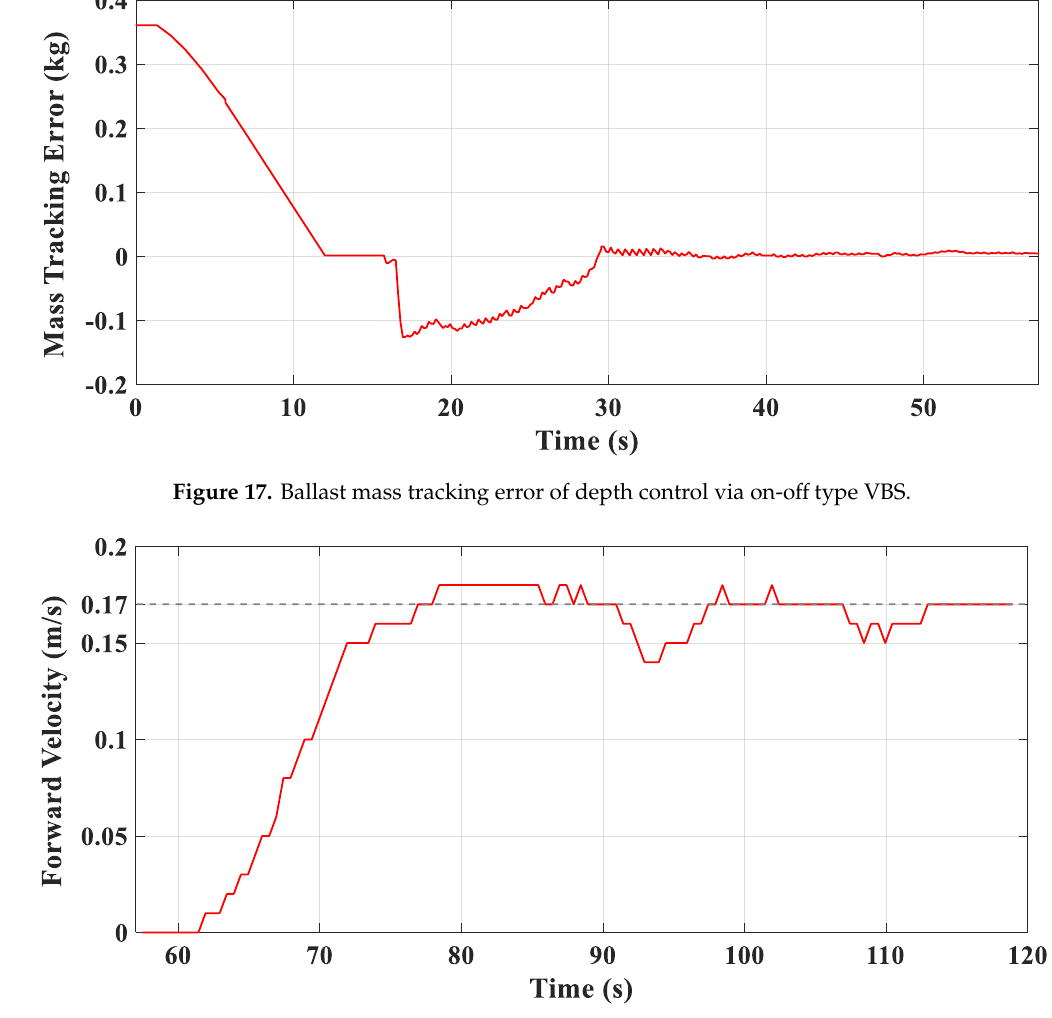
J. Mar. Sci. Eng. 2020 , 8 , 181 Figure 18. Forward velocity response at the stage of fins control. Figure 18. Forward velocity response at the stage of fins control. Figure 18. Forward velocity response at the stage of fins control.